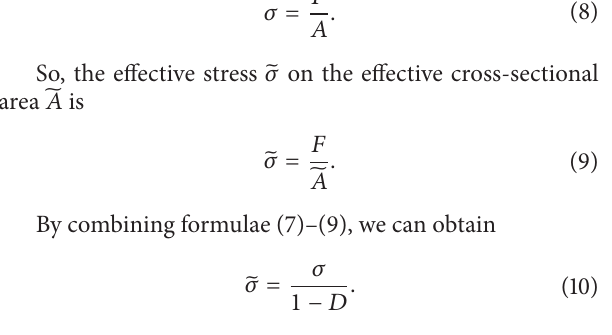
that the material is in the state of no damage, while 𝐷 = 1 corresponds to the complete damage state of the